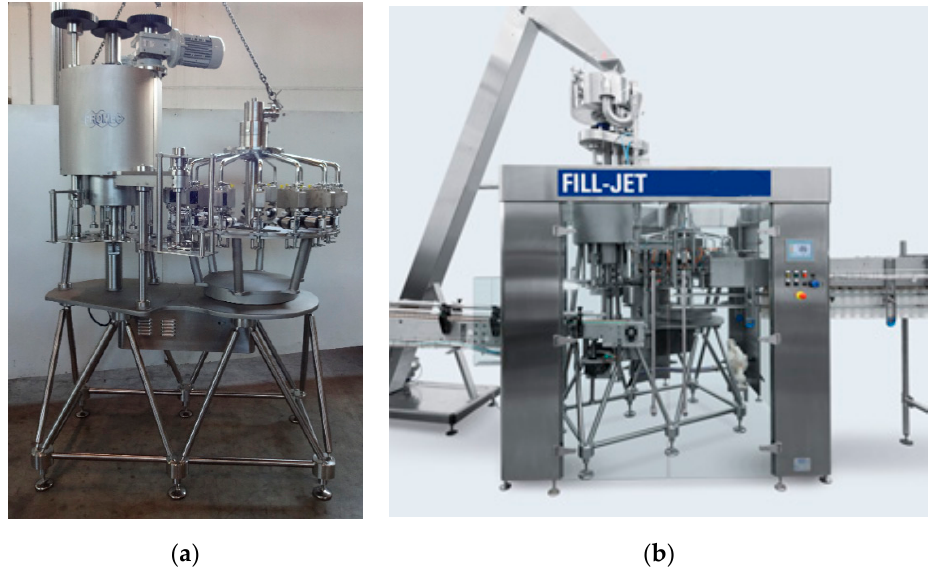
Figure 13. Prototype of the combined filler–capper unit with a FLEX base: ( a ) without and ( b ) with external